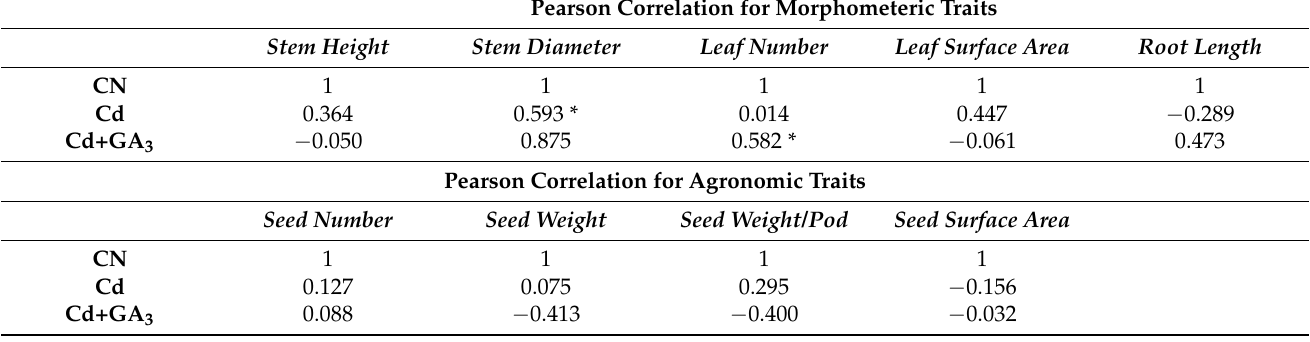
Table 3. Pearson correlation coefficient ( r ) for ten traits of plant fitness (stem height, stem diameter, leaf number, leaf surface area, and root length) and of agronomical attributes (seed number, seed weight, seed weight/pod, seed surface area) for Control versus Cd, Control versus Cd+GA 3 and Control versus GA 3